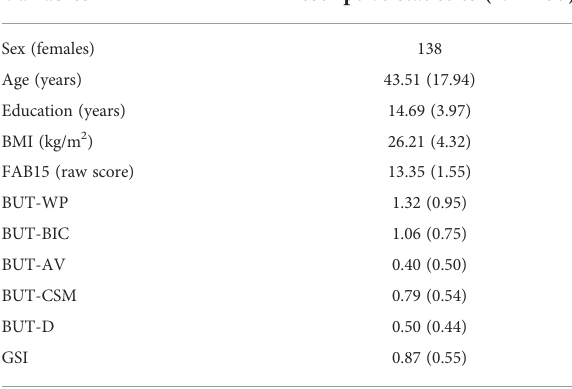
TABLE 1 Sample characteristics.